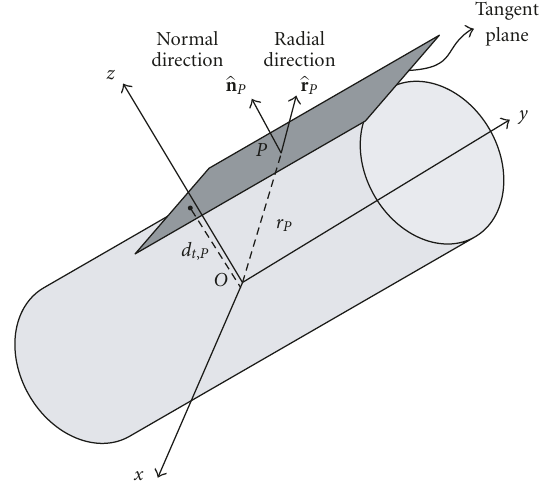
Figure 1: Radial and normal directions of a surface point.